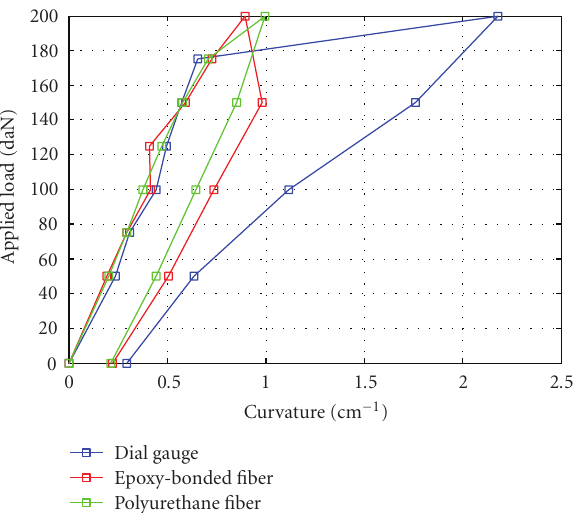
Figure 7: Applied load versus curvature. The latter wascalculated at the midsection using the dial strain gauge or the optical fiber sensor